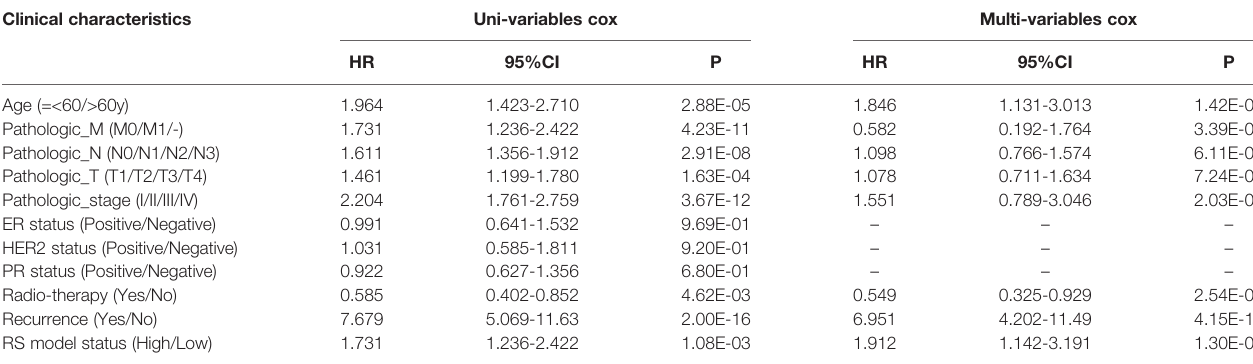
TABLE 2 | The univariate and multivariate Cox regression